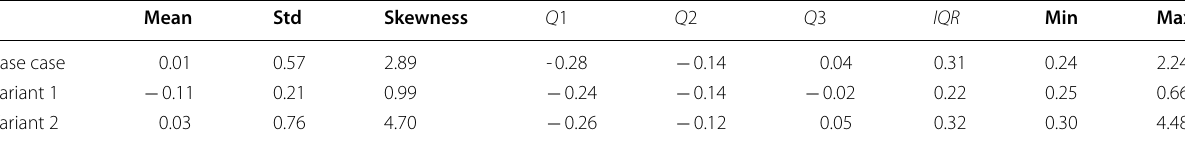
Table 2 Statistics of log‑transform travel time, log 10 t , of the three cases considered in this paper Mean Std Skewness Q